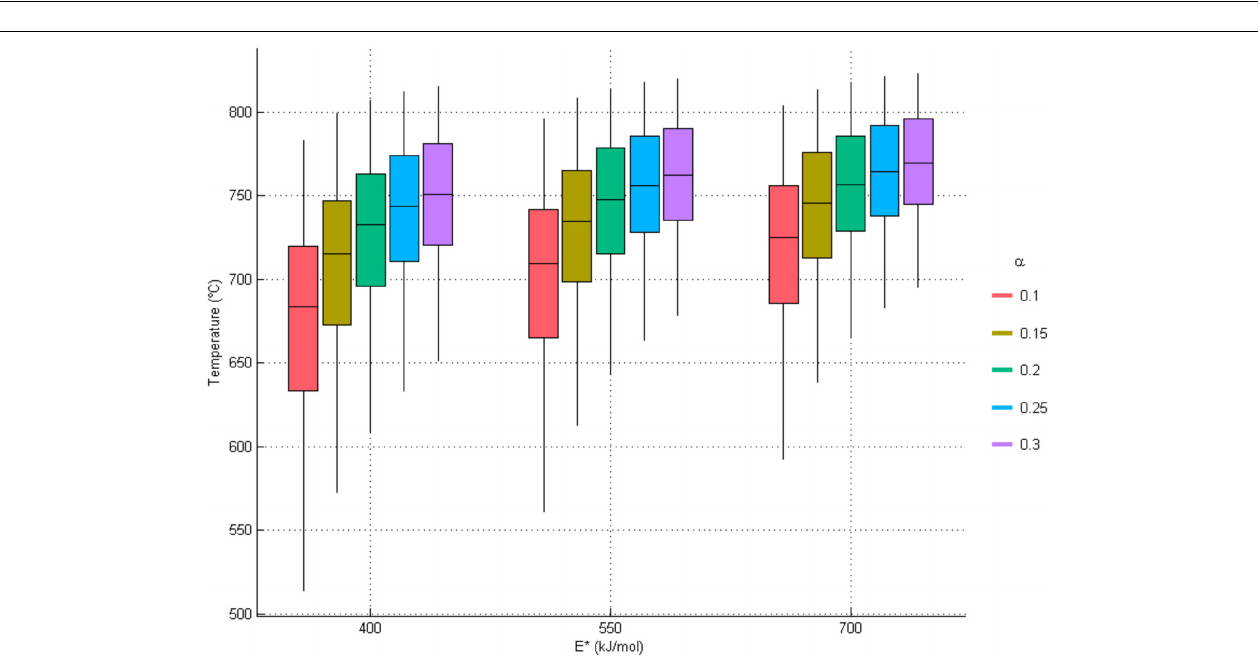
FIGURE 5 | Results of the spatial inversion of Q − 1 c accompanied with the chequer-board test for presenting the robustness of the tomography, and the mapping of the diagonal elements of the resolution matrix (RDE) and the hit count of ellipsoidal shells in each block (NEB). Image shows that the spatial inversion reconstructs satisfactory almost all study area, with a reduced quality only in the peripheral areas.